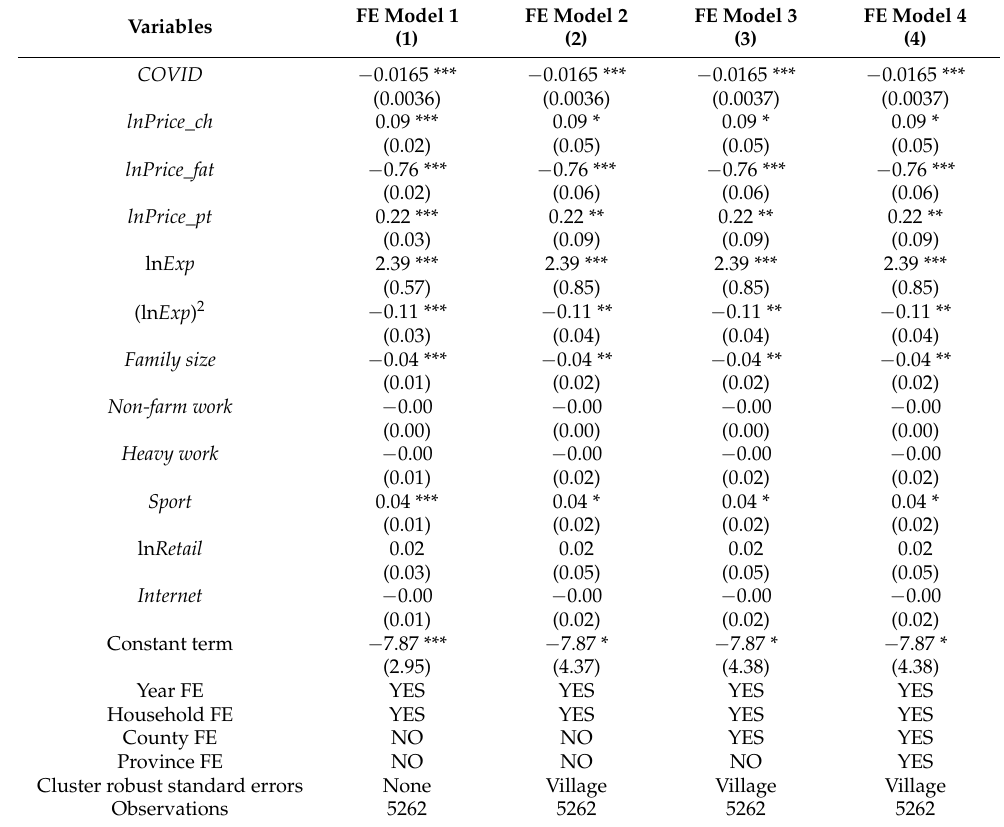
Table 5. Estimation results of the COVID-19 impact on fat